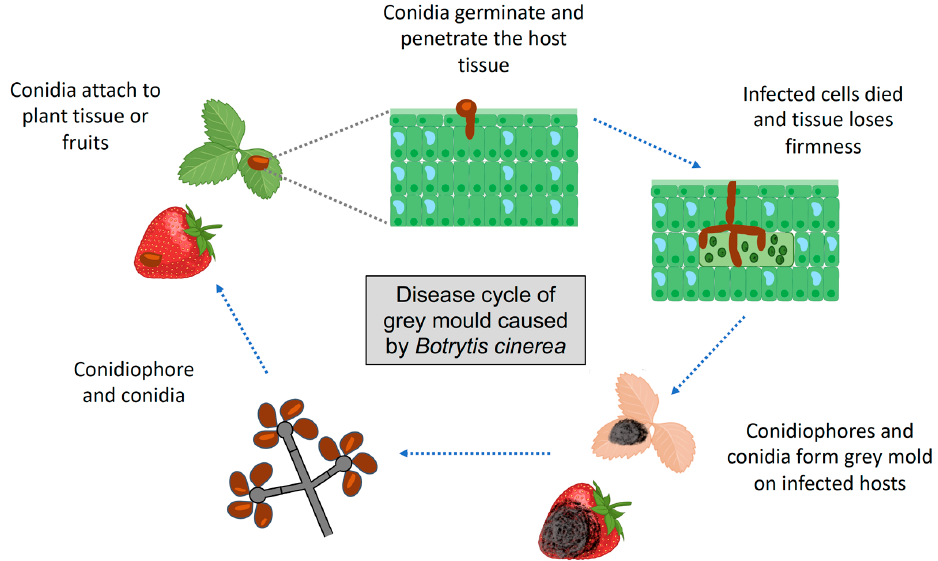
Figure 1. A summarised description of the disease cycle of grey mould caused by Botrytis cinerea in plant tissues and fruits.